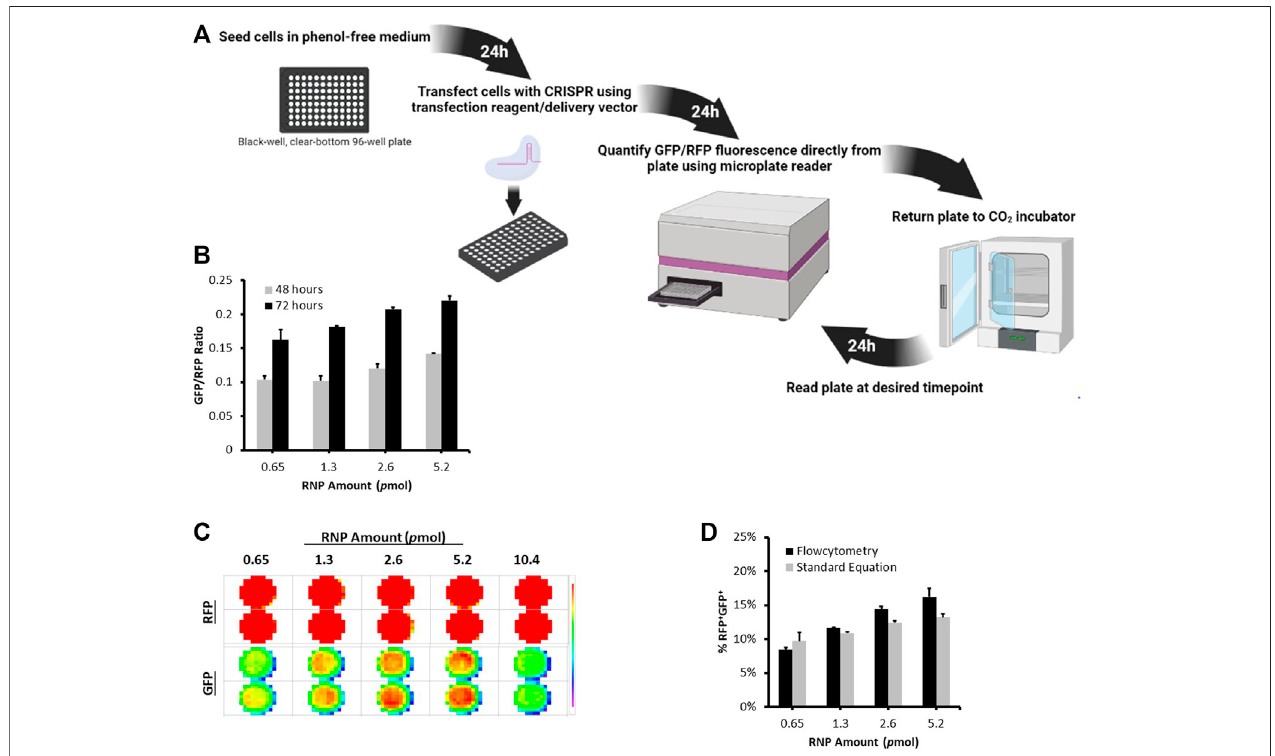
FIGURE 3 | Microplate Reader Approach to Quantifying CRISPR Nuclease Activity Using the Stable Reporter System. (A) A schematic illustration of the timeline work fl ow of the Microplate Reader Assay. Stable Reporter HEK293 cells were seeded at 10,000 per well in a black-well, clear-bottom, 96-well plate. The next day, cells were transfected with different amounts of Cas9/gRNA2 RNP using Lipofectamine CRISPRMAX. (B) The plate was scanned for RFP and GFP signal using FLUOstar ® Omega microplate at 48 and 72 h post transfection. (C) Fluorescence intensity Matrix scan output. (D) At 72 h, cells were also analyzed using fl owcytometry. The graph shows a comparison between the percentage of RFP + GFP + counted using fl owctomtery and RFP + GFP + values obtained from microplate reader using the formula: %RFP + GFP + = (3 (GFP/RFP)/5) * 100. Results are expressed as mean ± standard error of the mean of n = 3.